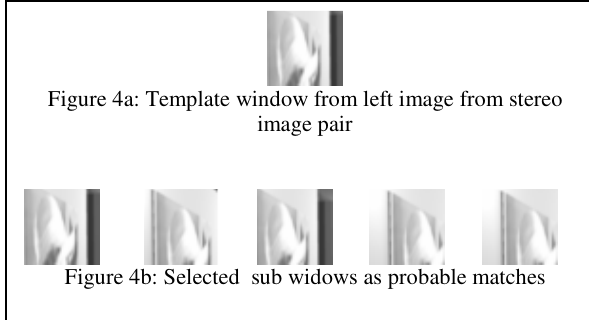
Figure 4b: Selected sub widows as probable matches